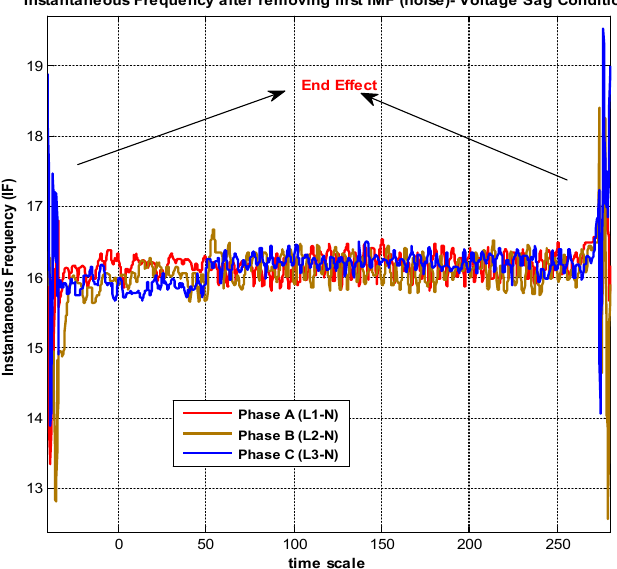
Fig. 10. IF corresponding to remove first imf normal condition of signal